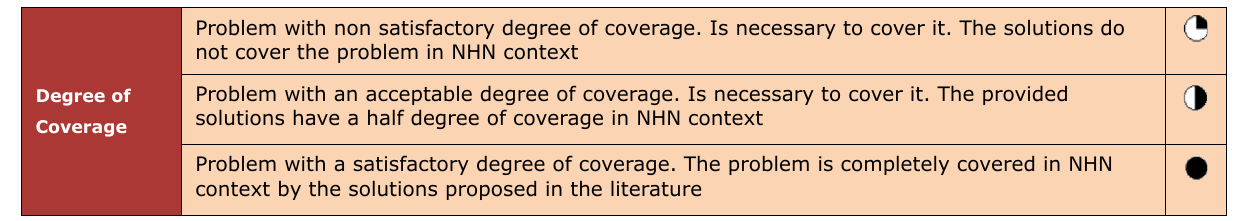
Table 2. Degree of Coverage of the problem